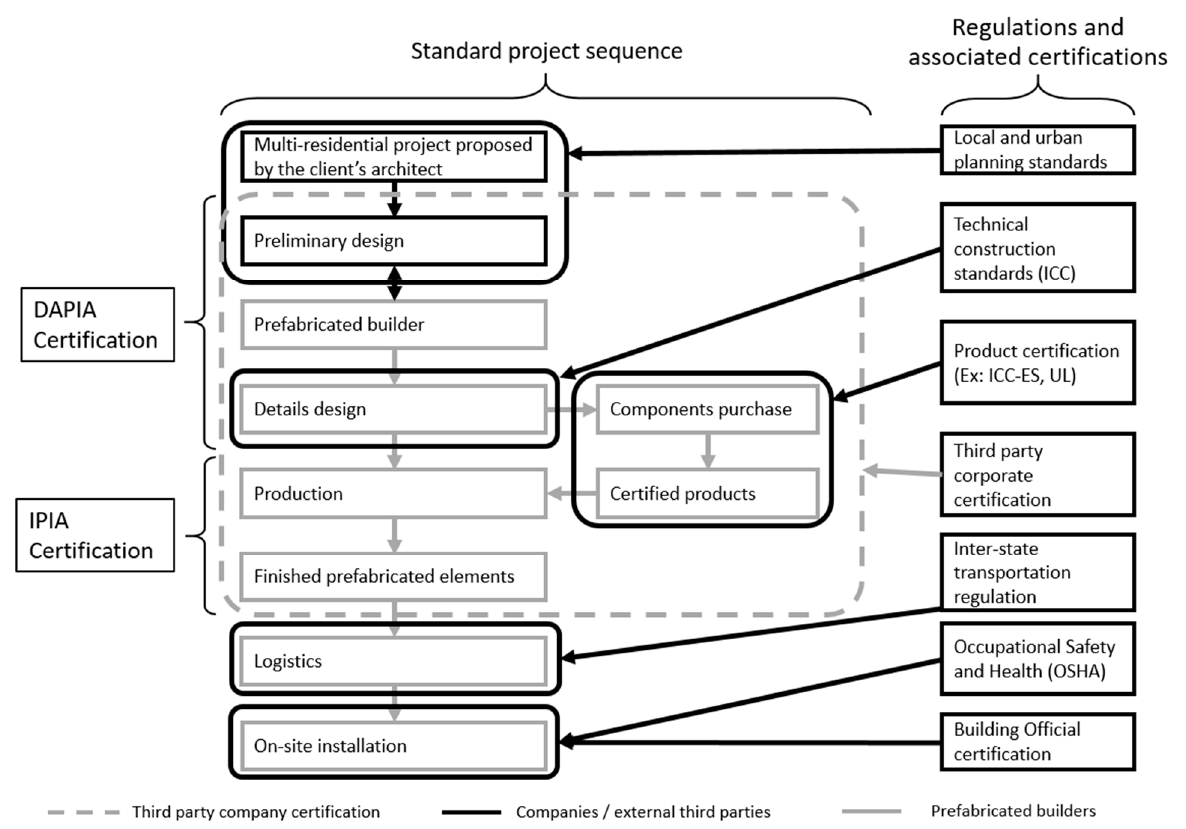
Figure 1. Certifications and regulations process map summary in the building construction industry in US. 2. Materials and Methods.